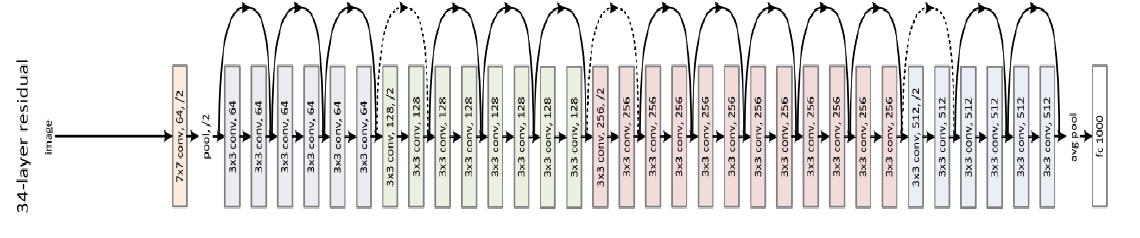
Figure 7. Example of 34 residual